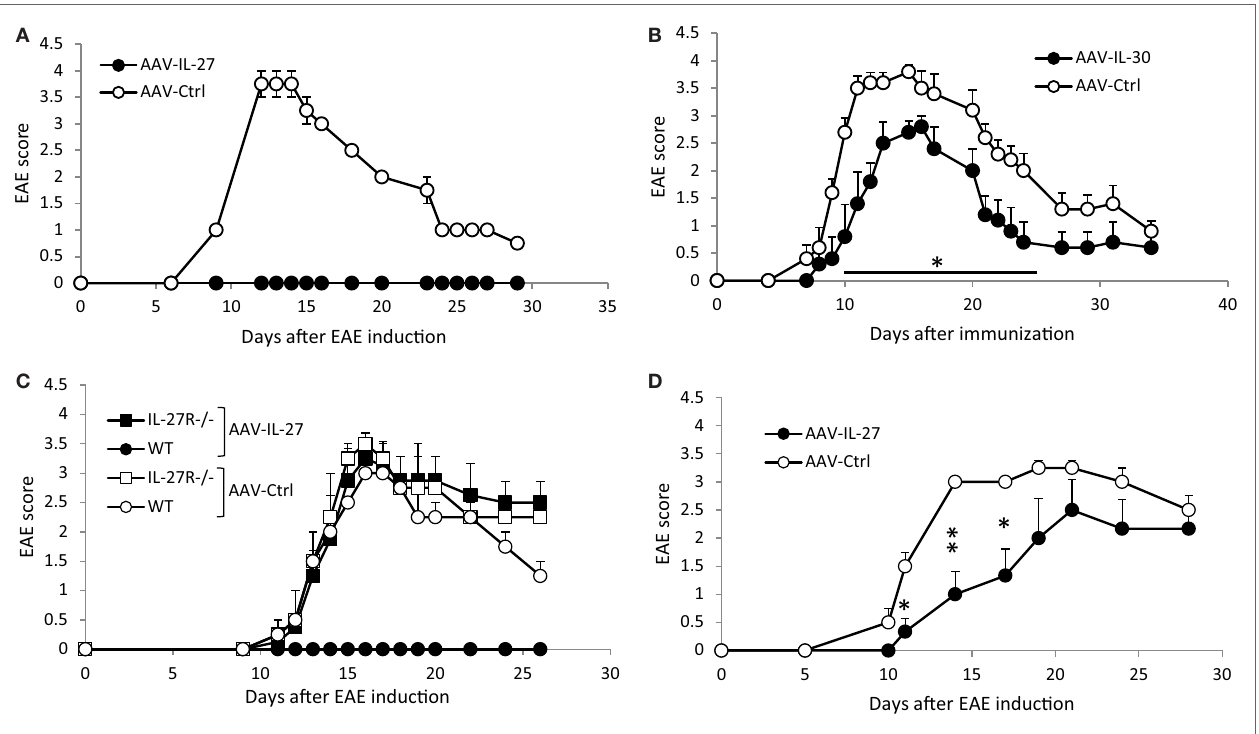
FigUre 2 | The effects of adeno-associated viral vector (AAV)-delivered interleukin-27 (IL-27) or IL-30 in the prevention of experimental autoimmune encephalomyelitis (EAE) development. C57BL6 mice (a,B) , IL-27R α − / − (c) , or 2D2 TCR transgenic mice (D) were treated with AAV-IL-27, AAV-IL-30, or AAV-ctrl virus i.m. at a dose of 2 × 10 11 DRP/mouse. One week later, EAE was induced in the AAV-treated mice. Five mice per group were used in these experiments. Data shown represent two (c,D) to three (a,B) experiments with similar results. EAE scores are expressed as means ± SD. Statistical analysis was performed using the unpaired Student’s t -test. * P < 0.05; ** P <